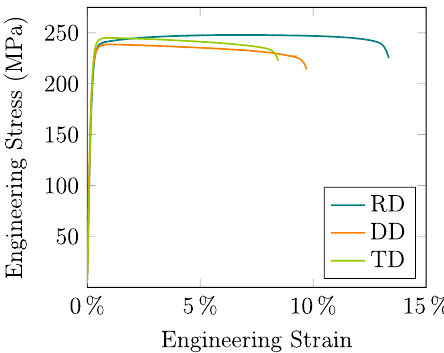
Figure 6. Average experimental engineering stress–strain curves for the RD, DD, and TD tensile samples obtained after three tests per direction.